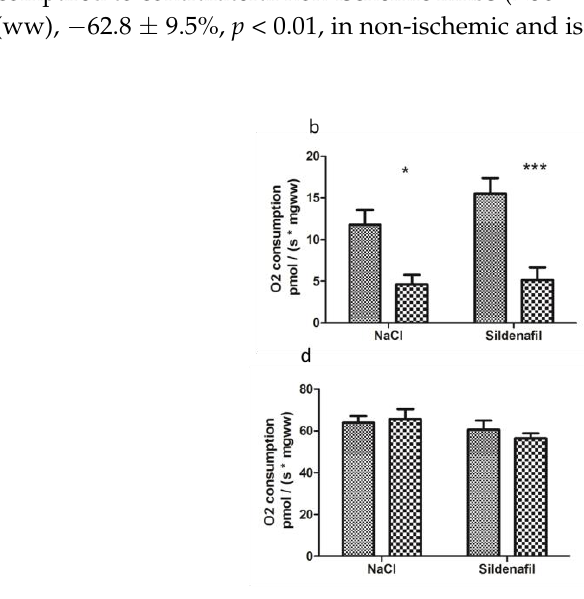
Figure 2. Mitochondrial respiration in ischemic and non-ischemic gastrocnemius in mice treated (n = 10) or not (n = 8) with sildenafil; ( a ): V 0 corresponds to the basal O 2 consumption, with glutamate and malate as substrates. ( b ): V max corresponds to the ADP-stimulated respiration, with glutamate and malate as substrates. ( c ): V succ represents the activation of all complexes (I, II, III, IV, V). ( d ): V asc/TMPD represents the complex IV contribution to the global mitochondrial respiratory rate. For both NaCl and Sildenafil groups: left column, non-ischemic contralateral limb. Right column: Ischemic limb. Results are expressed as means ± SEM. *: p < 0.05; **: p < 0.01 and ***: p < 0.001, as compared to the contralateral limb of the same